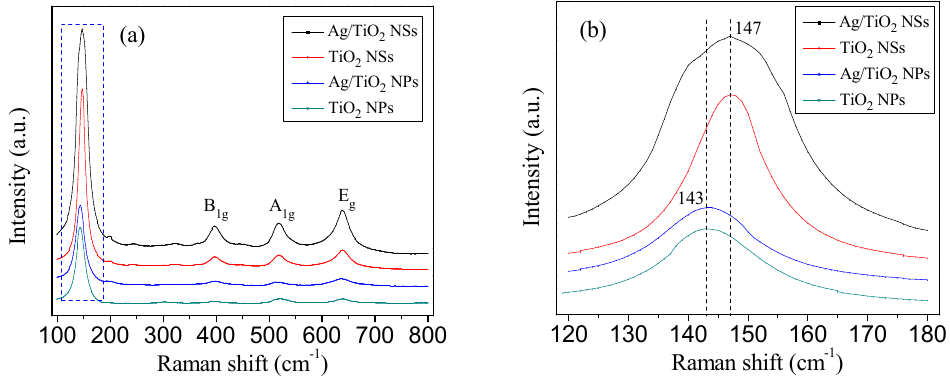
Figure 5. Raman spectra of different samples ( a ) and the magnified Raman spectra from 120 to 180 cm − 1 ( b ).